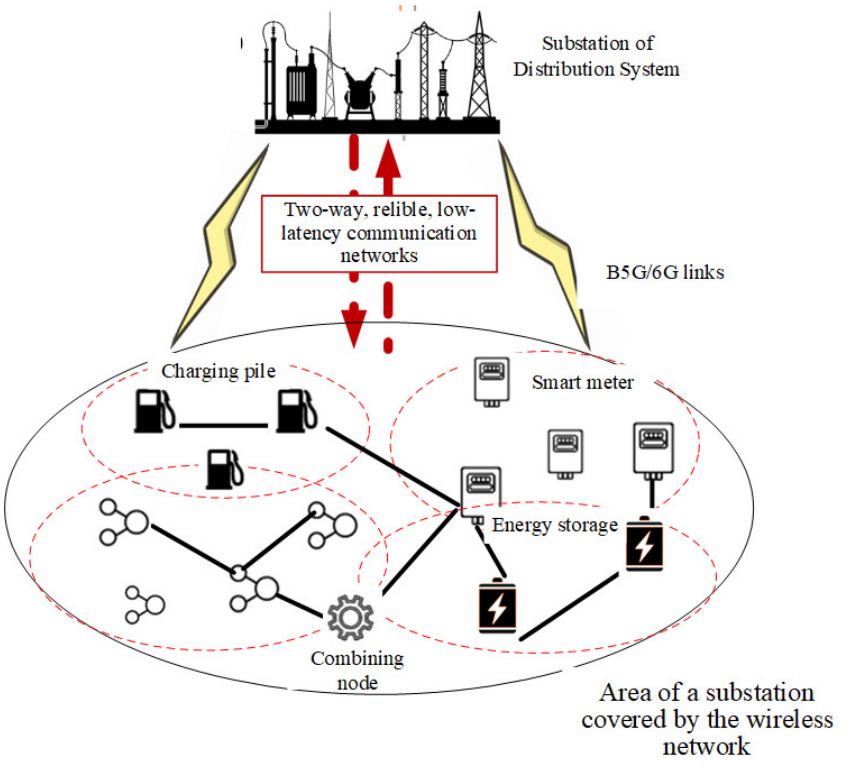
Figure 1. The communication networks for electric power systems accommodating multiple nodes and